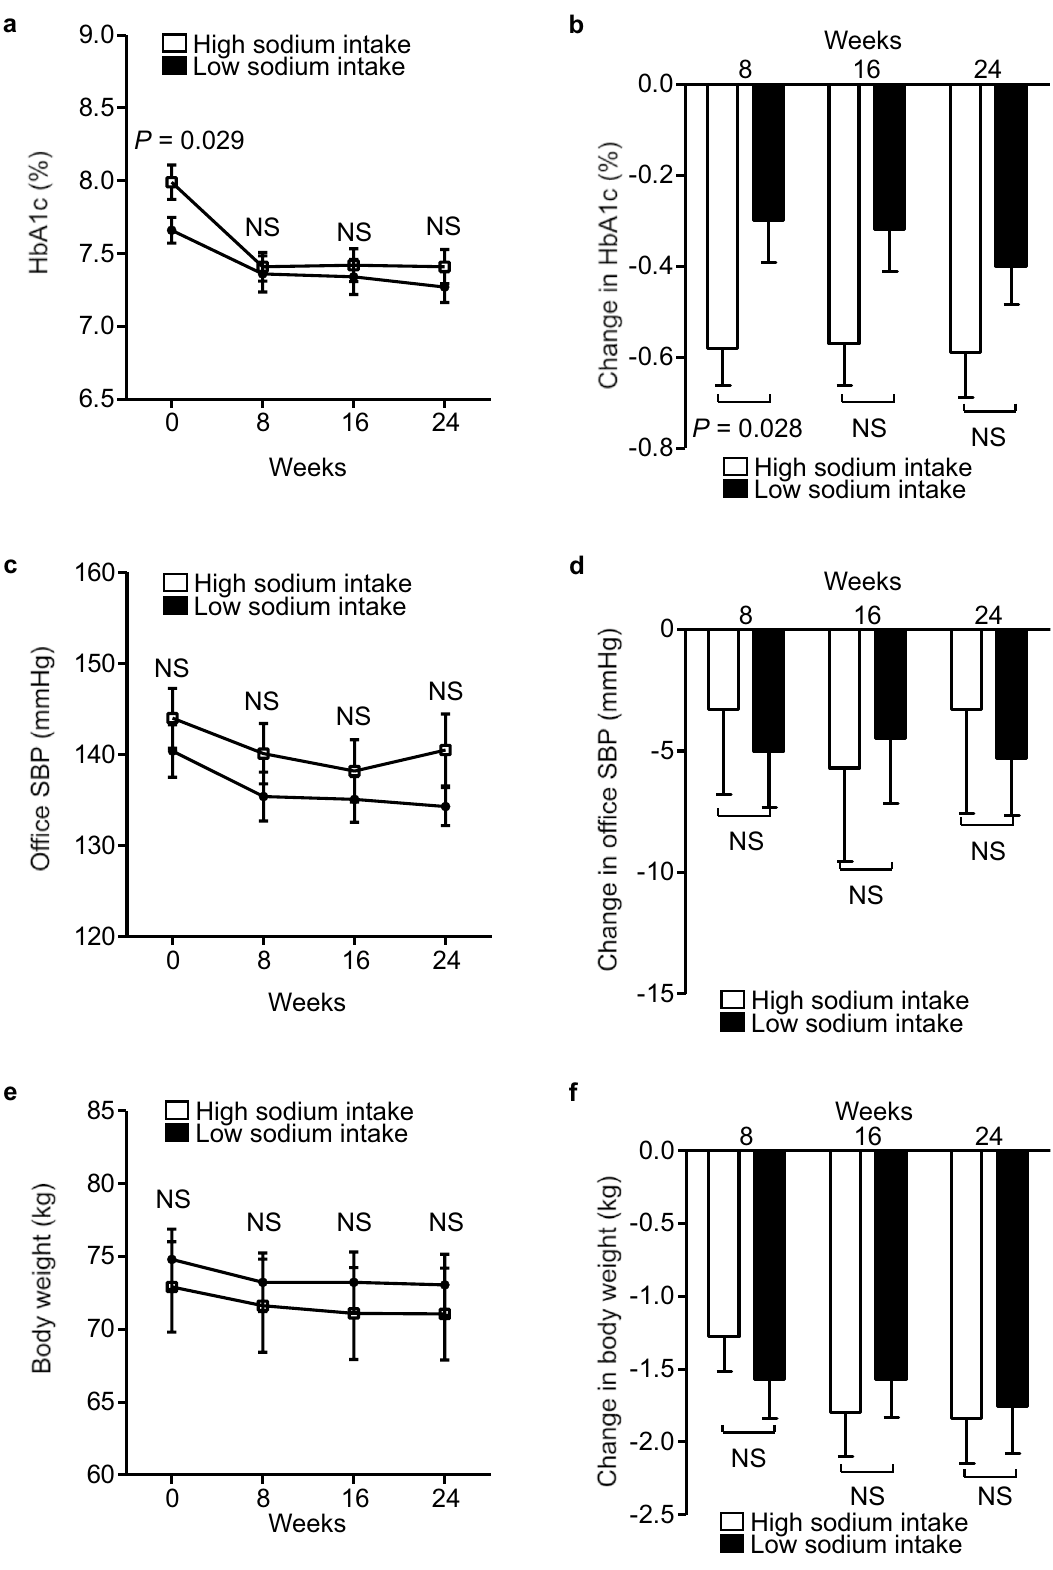
Figure 2. Effects of add-on dapagliflozin therapy on the glucose metabolism, clinic-measured blood pressure, body mass, and body mass index of the HS and LS groups. (a) HbA1c, (c) fasting blood glucose (FBG), (e) clinic systolic blood pressure (SBP), (g) clinic diastolic blood pressure (DBP), (i) body mass, and (k) body mass index (BMI) in dapagliflozin-treated patients during the 24-week study period. Change in (b) HbA1c, (d) FBG, (f ) clinic SBP, (h) clinic DBP, (j) body mass, and (l) BMI during the 24-week study period. Eighty-four DKD patients were allocated to a high sodium intake (HS) group (open square) or a low sodium intake (LS) group (filled square), according to their median urinary sodium-to-creatinine ratio at baseline. Values are mean ± SE. The differences in the effects of dapagliflozin treatment between the two groups were analyzed using unpaired t -tests at each visit. NS, not